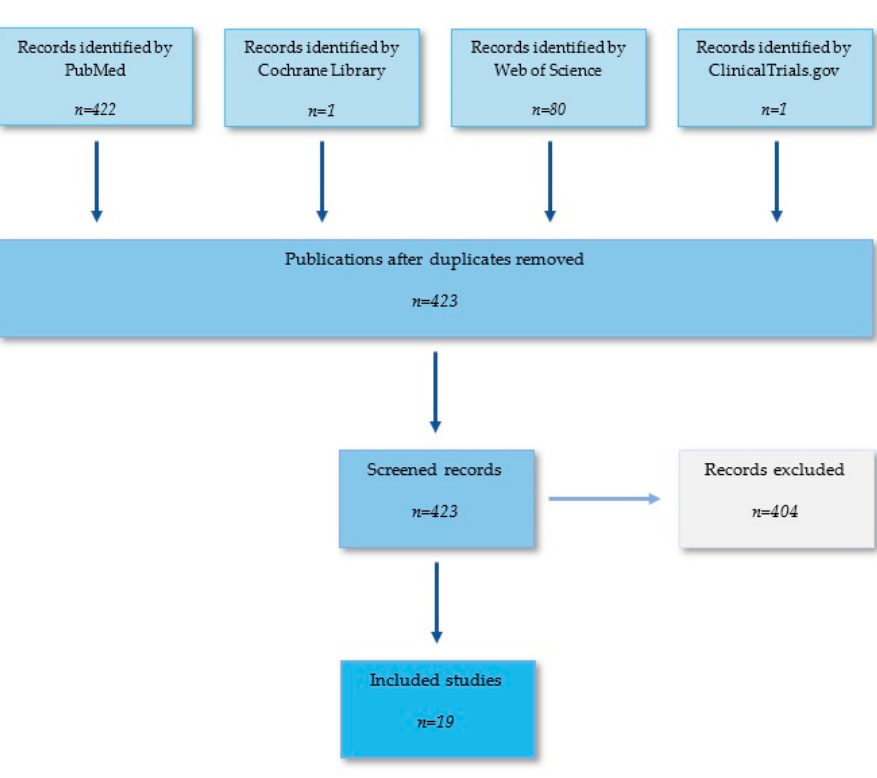
Figure 4. Flow graph illustrating searching method.